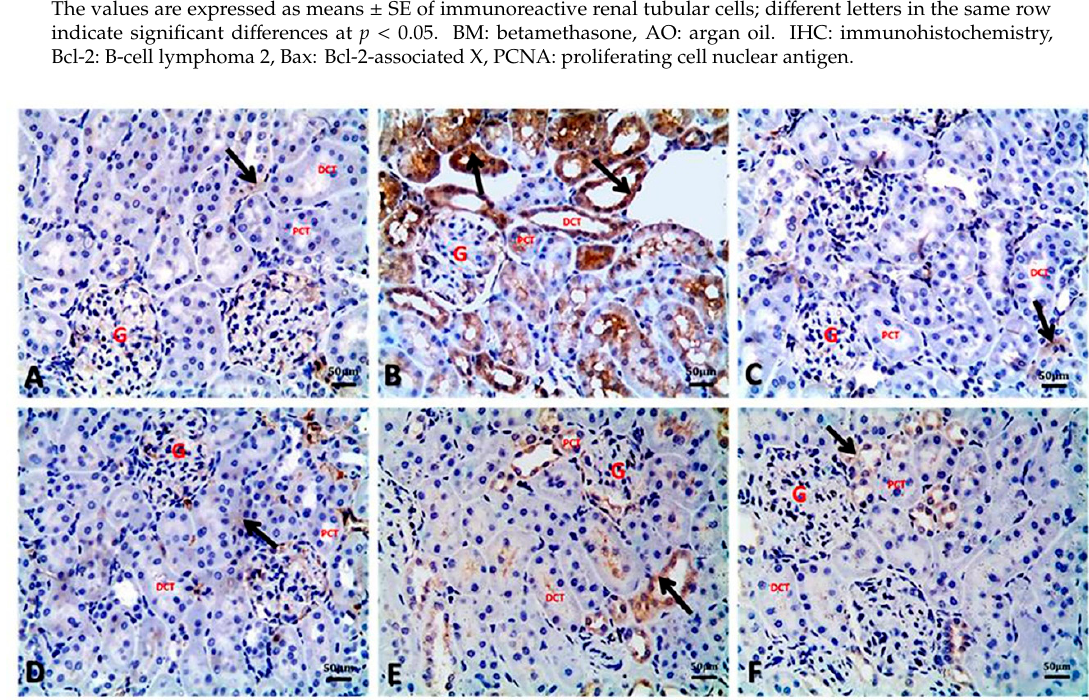
Figure 4. Representative photomicrographs of immuno-histochemical localization of Bax in kidney sections of different groups (Bax IHC, bar = 50 µm). ( A ) Control group showing slight cytoplasmic expression of Bax immune-staining in the renal tubular cells. ( B ) BM group showing marked cytoplasmic immune-staining of Bax in most renal tubular cells of both proximal and distal convoluted tubules. ( C ) AO/0.5 and ( D ) AO/1 showing slight cytoplasmic immune-staining of Bax as control group. ( E ) BM + AO/0.5 showing mild cytoplasmic immune-staining of Bax within some renal tubules. ( F ) BM + AO/1 showing mild cytoplasmic immune-staining of Bax within the renal tubular cells.